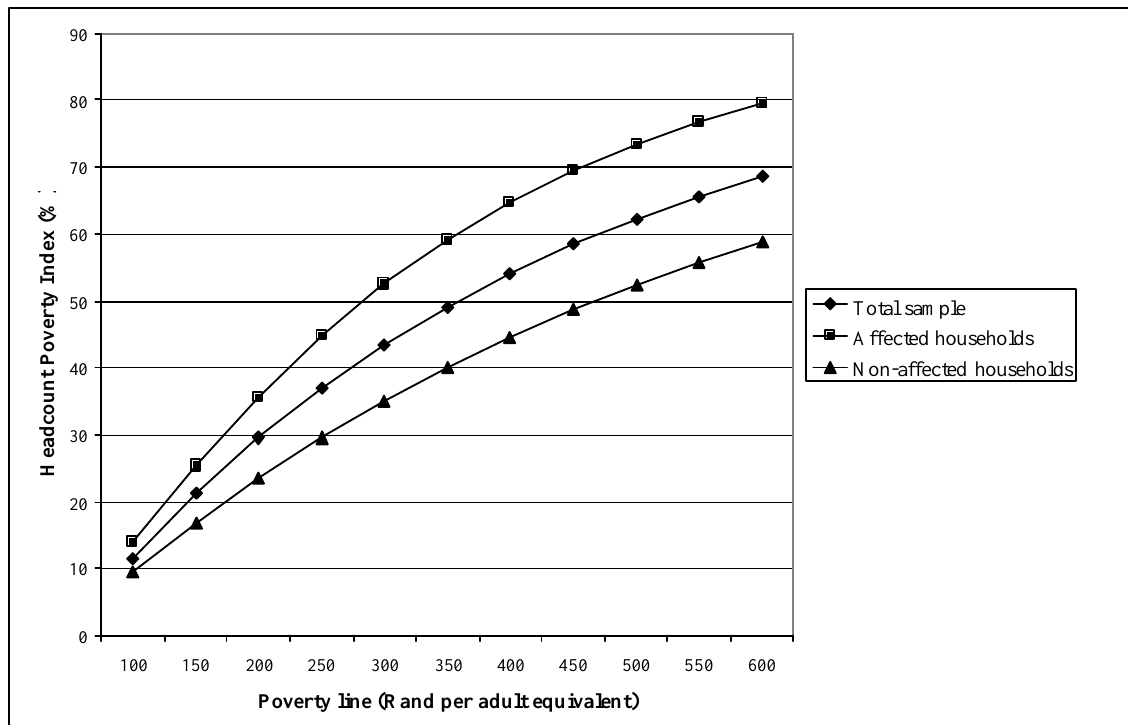
Figure 2: Incidence of poverty in affected and non-affected households (wave I)